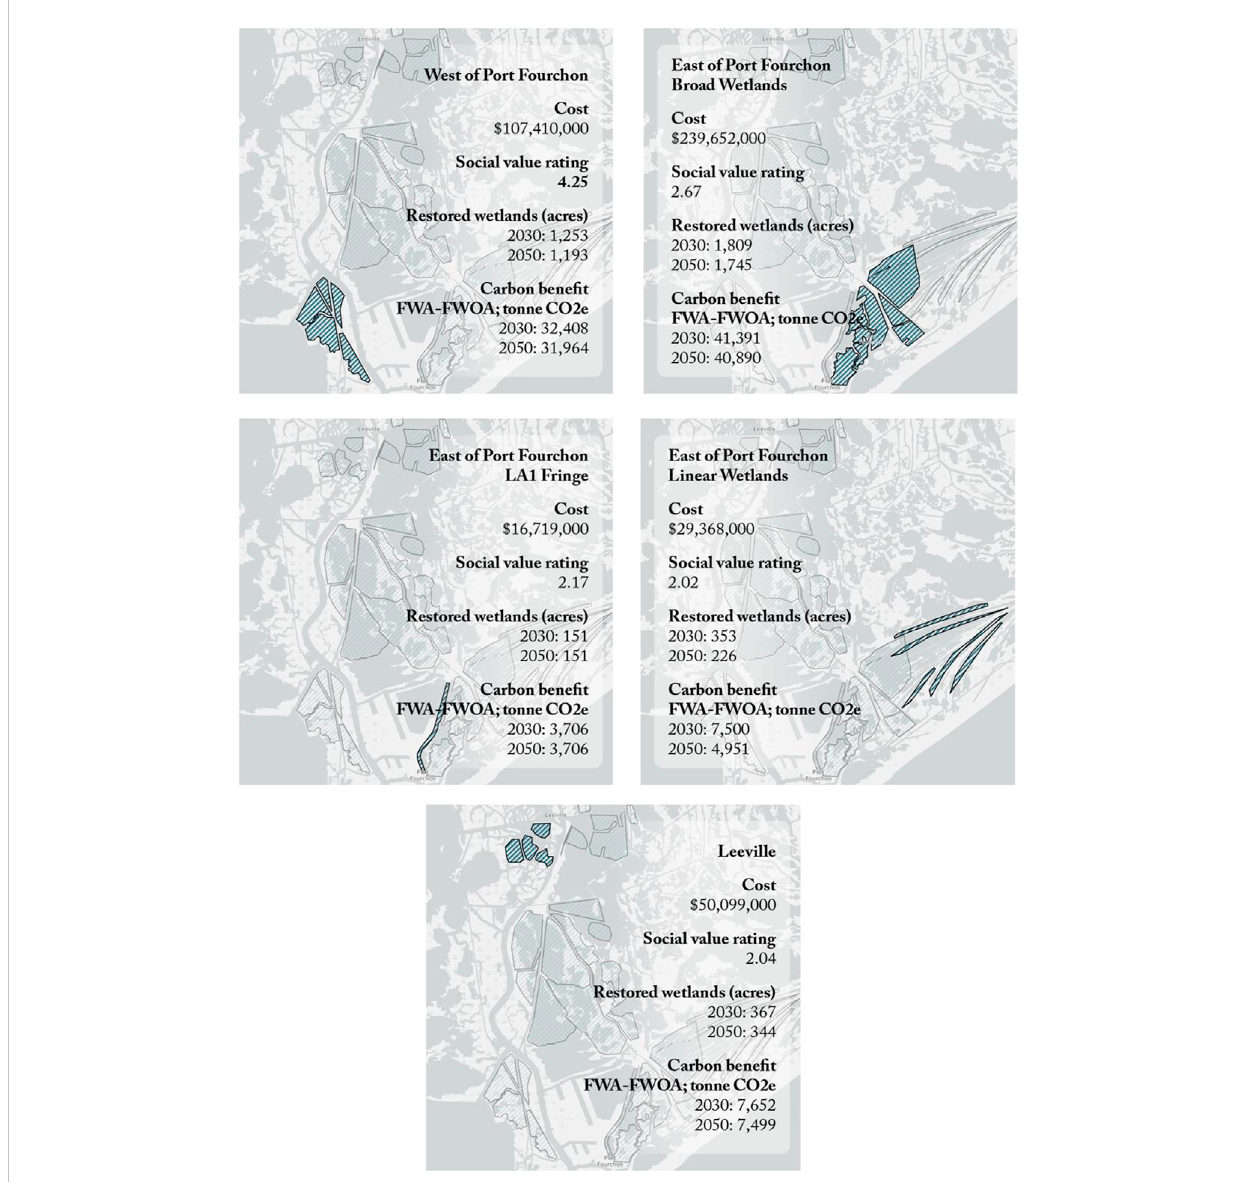
FIGURE 3 Model result for each wetlands restoration project grouping based on model projections from 2020 to